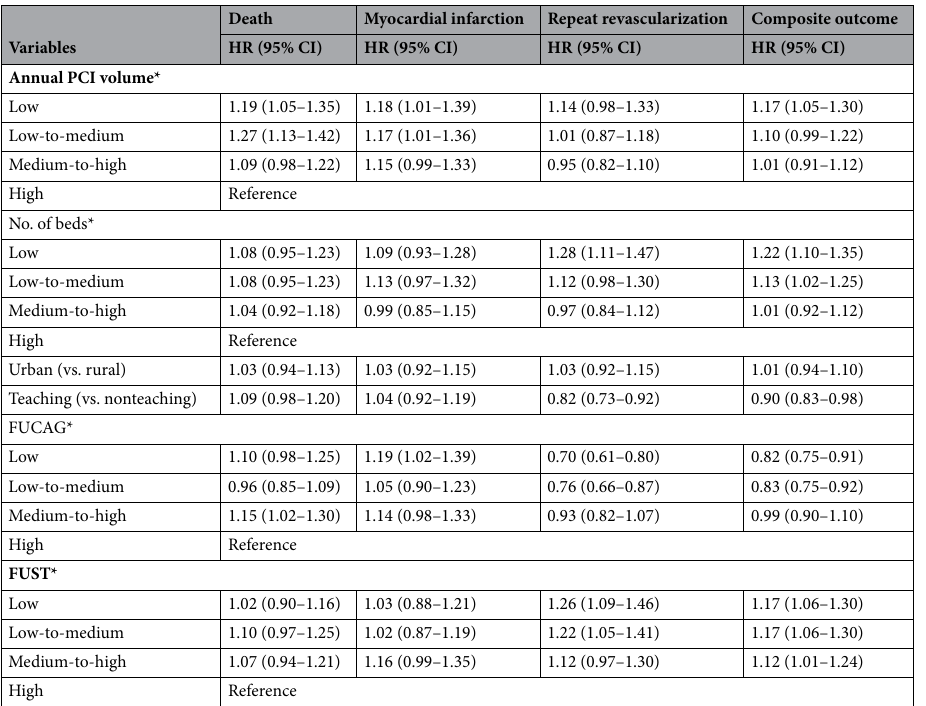
Table 5. Hospital factors associated with clinical outcomes. *Low indicates first quartile, low-to-medium second quartile, medium-to-high third quartile, and high fourth quartile. CI confidence interval, FUCAG follow-up invasive coronary angiography, FUST follow-up stress testing, HR hazard ratio, PCI percutaneous coronary